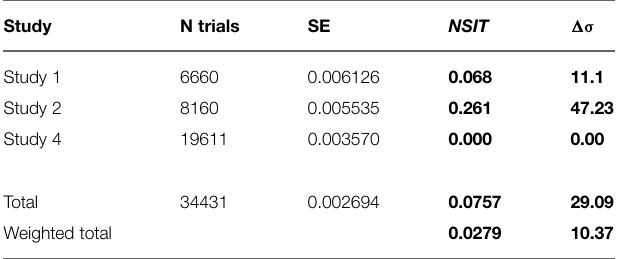
TABLE 1 | Results of the three